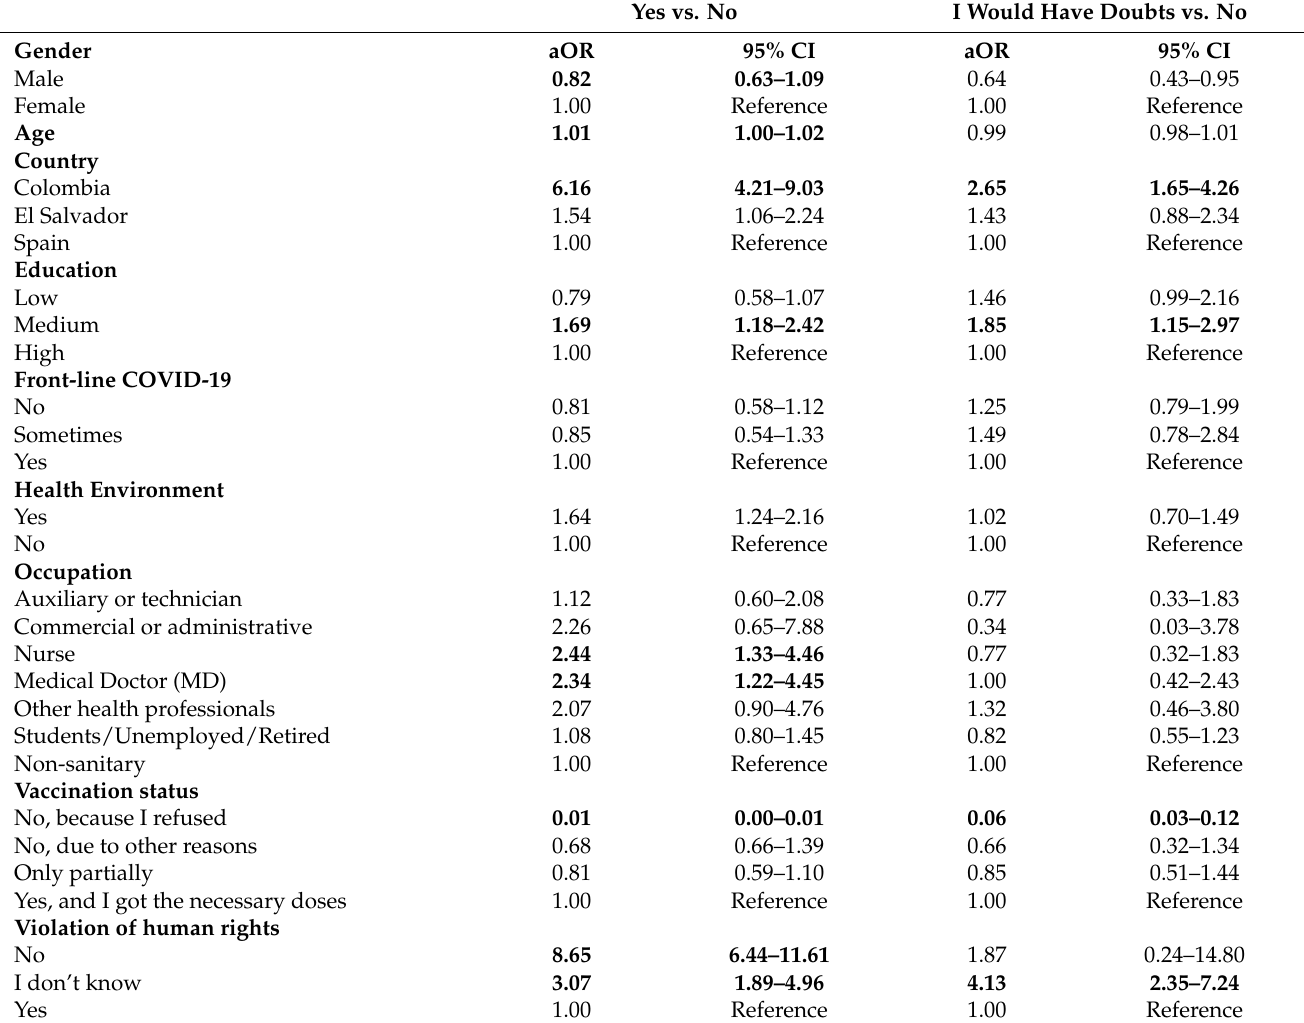
Table 4. Predictor factors of agreeing to be vaccinated with a booster and additional subsequent doses if offered (reference: no). Results from Multinomial Logistic Regression Models. Yes vs.